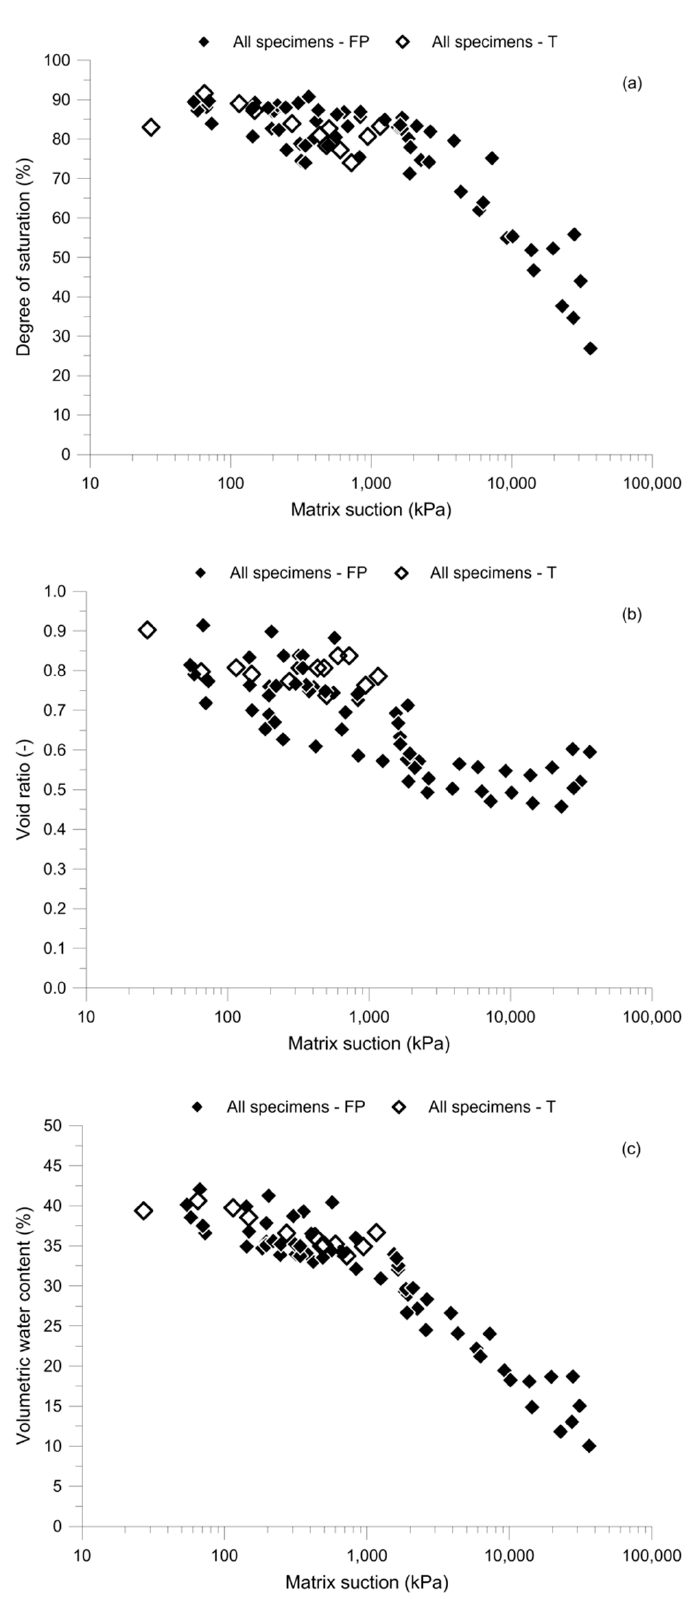
Figure 9. Water retention data of all the specimens (tested with both the filter paper technique, FP, and high-capacity tensiometers, T) reported in terms of matrix suction against: ( a ) degree of saturation; ( b ) void ratio; ( c ) volumetric water content.